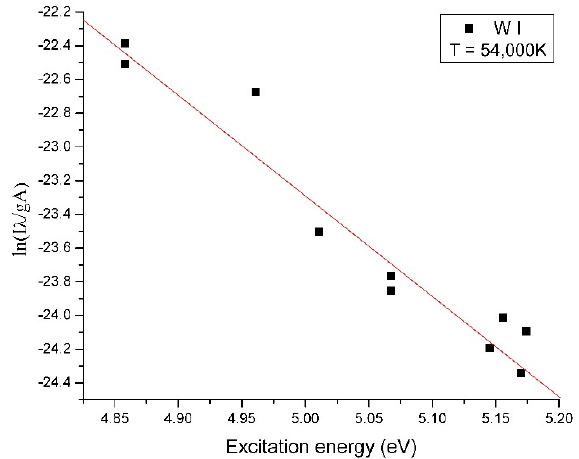
Figure 6. The Boltzmann plot and electron temperature for tungsten ions.